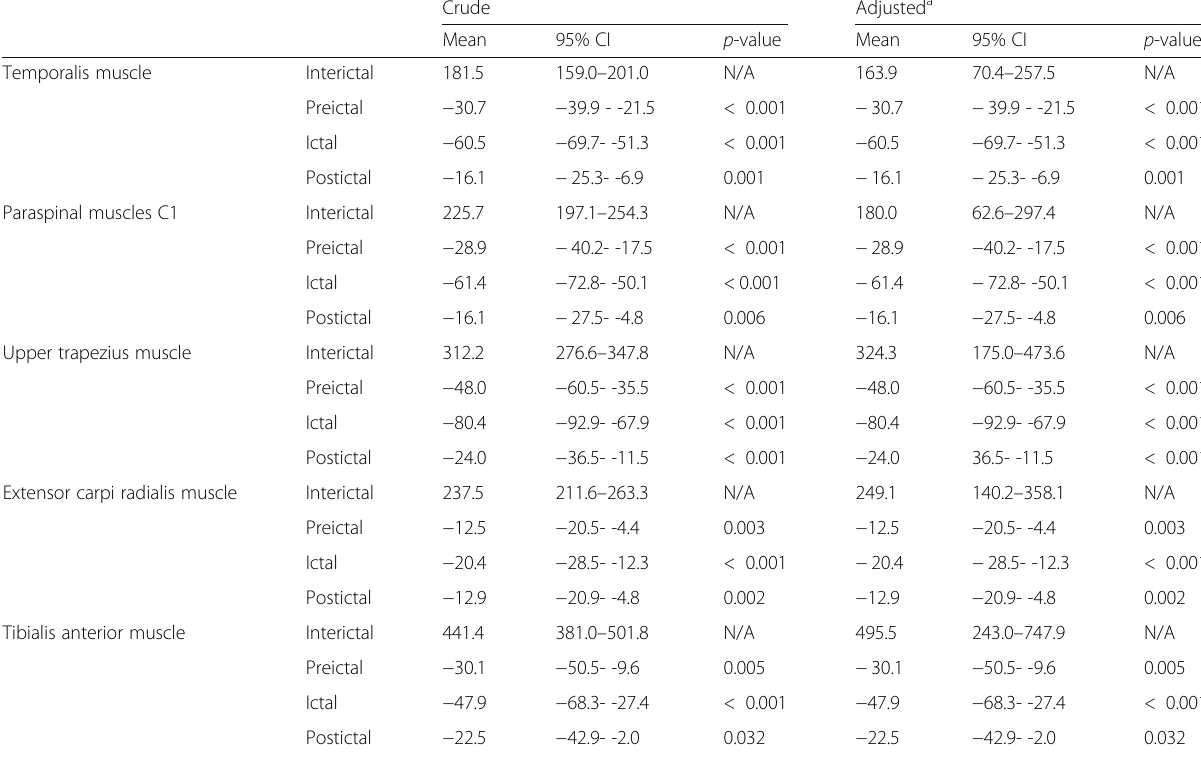
Table 2 Differences in pressure pain thresholds for the preictal, ictal and postictal phase compared to the interictal phase in people with migraine (dominant